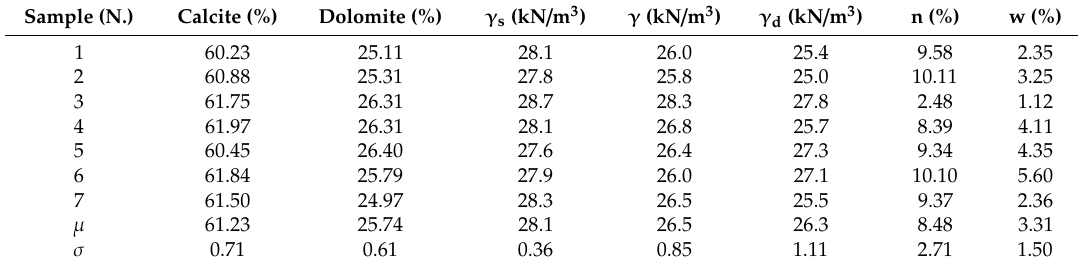
Table 1. Main physical properties of the dolomitic limestones. Key: γ s = material density; γ = unit weight; γ d = dry density; n = porosity; w = water content; µ = mean value; σ = standard deviation. Sample (N.)